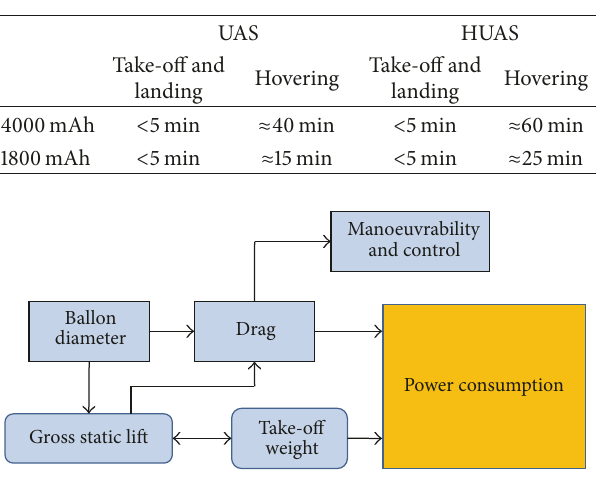
Table 9: HUAS versus UAS endurance.